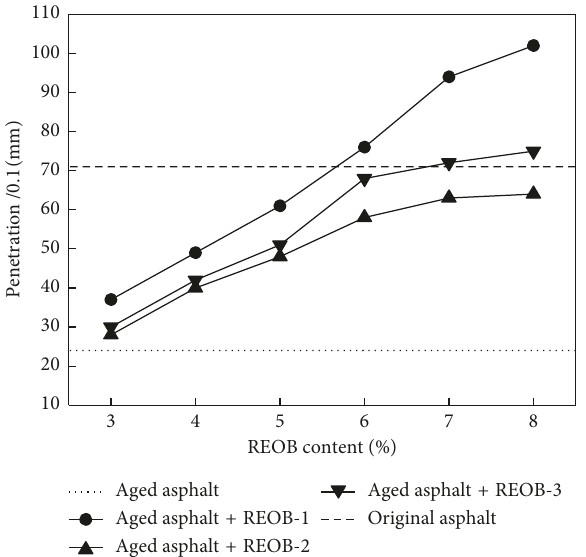
Figure 2: Influence of three types of REOB on softening point of aged asphalt. Figure 1: Influence of three types of REOB on penetration of aged